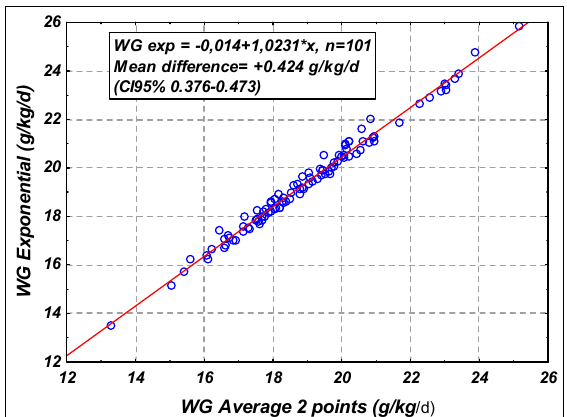
Figure 1. Evaluation of growth velocity by the exponential and the average 2 points methods.